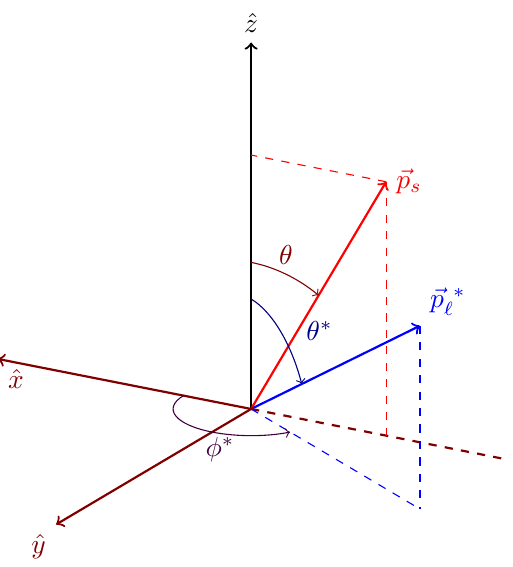
Figure 2. De(cid:12)nition of the right-handed coordinate system with ^ x , ^ y , and ^ z de(cid:12)ned as shown from the momentum directions of the W boson, ^ q the top-quark rest frame. The angles (cid:18) * and (cid:30) * indicate the direction of the lepton momentum, ^ p * while the angle (cid:18) indicates the direction of the spectator-quark momentum, ^ p s , in this coordinate